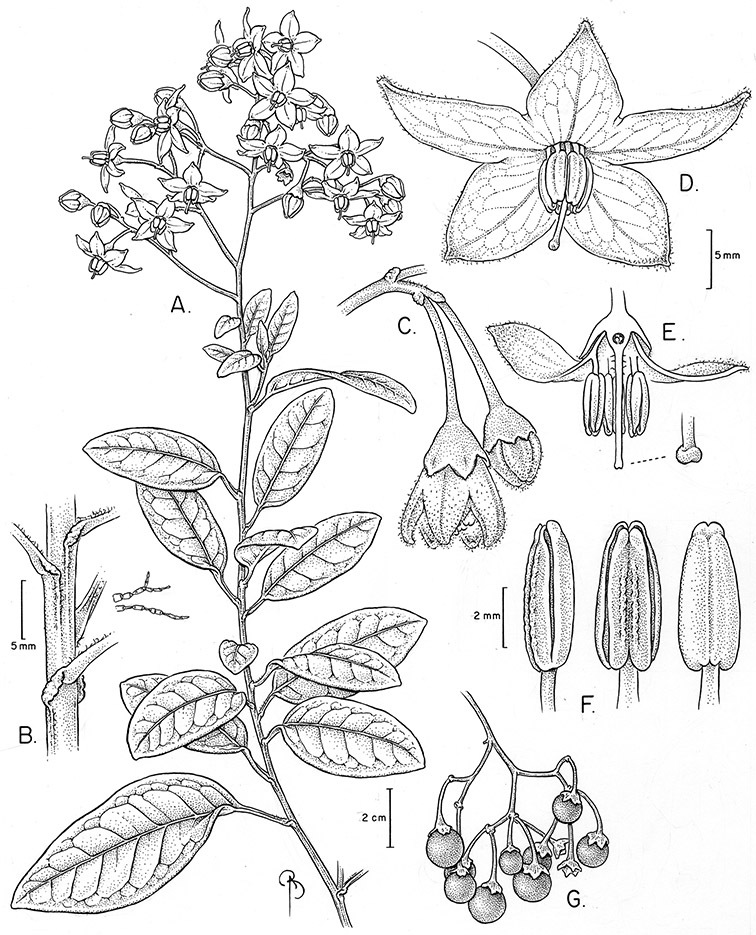
Solanum sanchez-vegae S. Knapp. (A–F drawn from Smith & Sanchez-Vega 7524
G from Hutchison et al. 5738). Originally published in Knapp (2010). Illustration by Bobbi Angell.